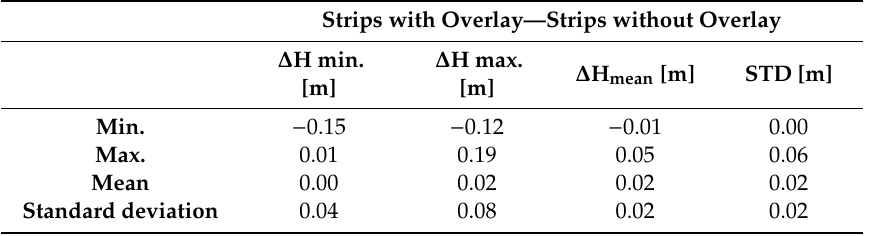
Table 11. Di ff erences in statistical characteristics for height di ff erences between strips with and without overlay. (Methodology v2). (where: H—height, STD—standard deviation). Strips with Overlay—Strips without